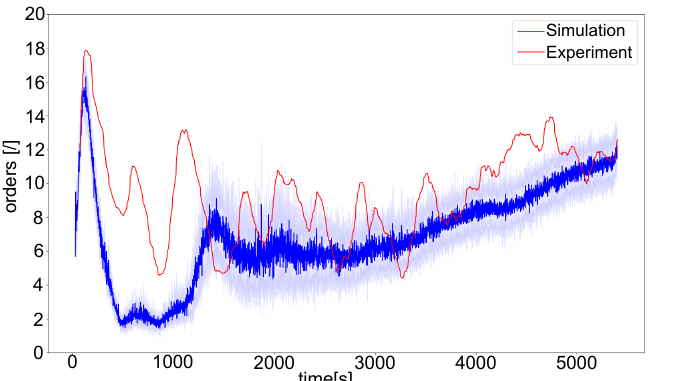
Figure 14. Comparison of amount of services on the market between the experimental and simula- tion results.